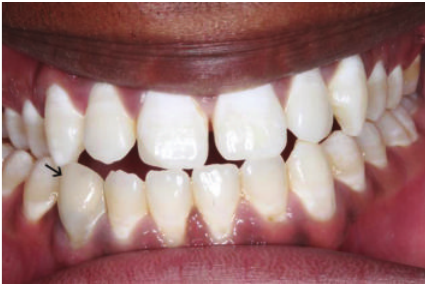
Figure 4: After treatment: following composite buildup and